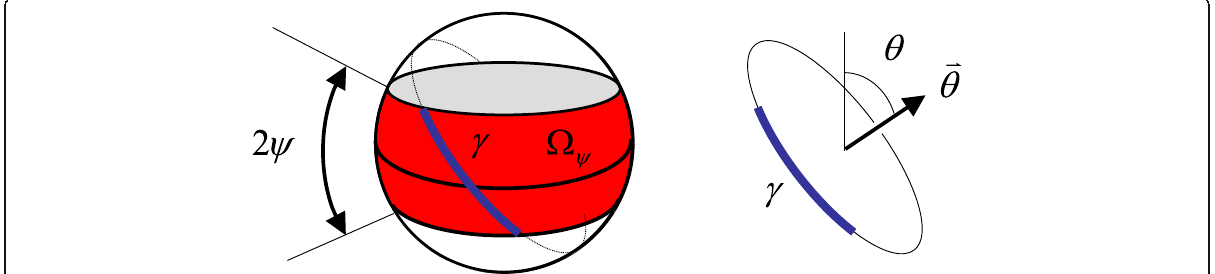
Fig. 2 The definition of the Ω ψ and the arc length γ , which is a part of a great